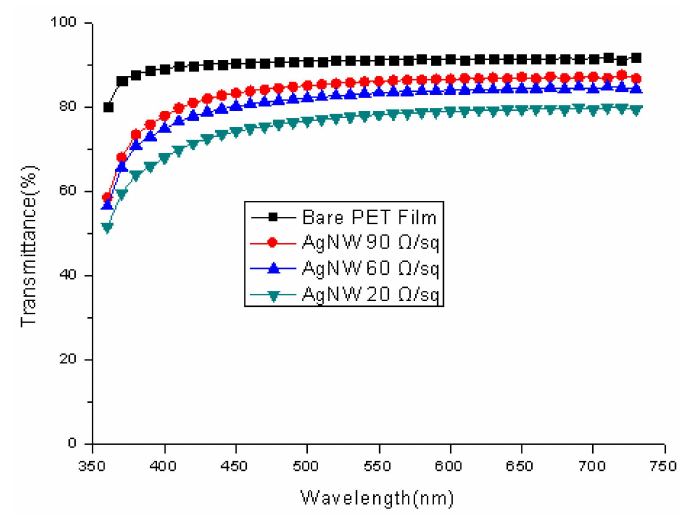
Figure 7. Transmittance and sheet resistance of AgNW-PET film made by spray coating. The SEM image of the AgNW-PET film and XRD peak of AgNWs are shown in Figure 8 in which the crystal lattice constant of AgNWs was 4.088 Å exhibiting face-centered cubic crystal structure of silver. The bending test of AgNW-PET and ITO-PET film shows that the former is stable up to 10,000 bending stress while the latter shows rapid increase of sheet resistance from 8000 bending motions suggesting that AgNW-PET film can be used in the fabrication of flexible TSP and flexible display substrate.